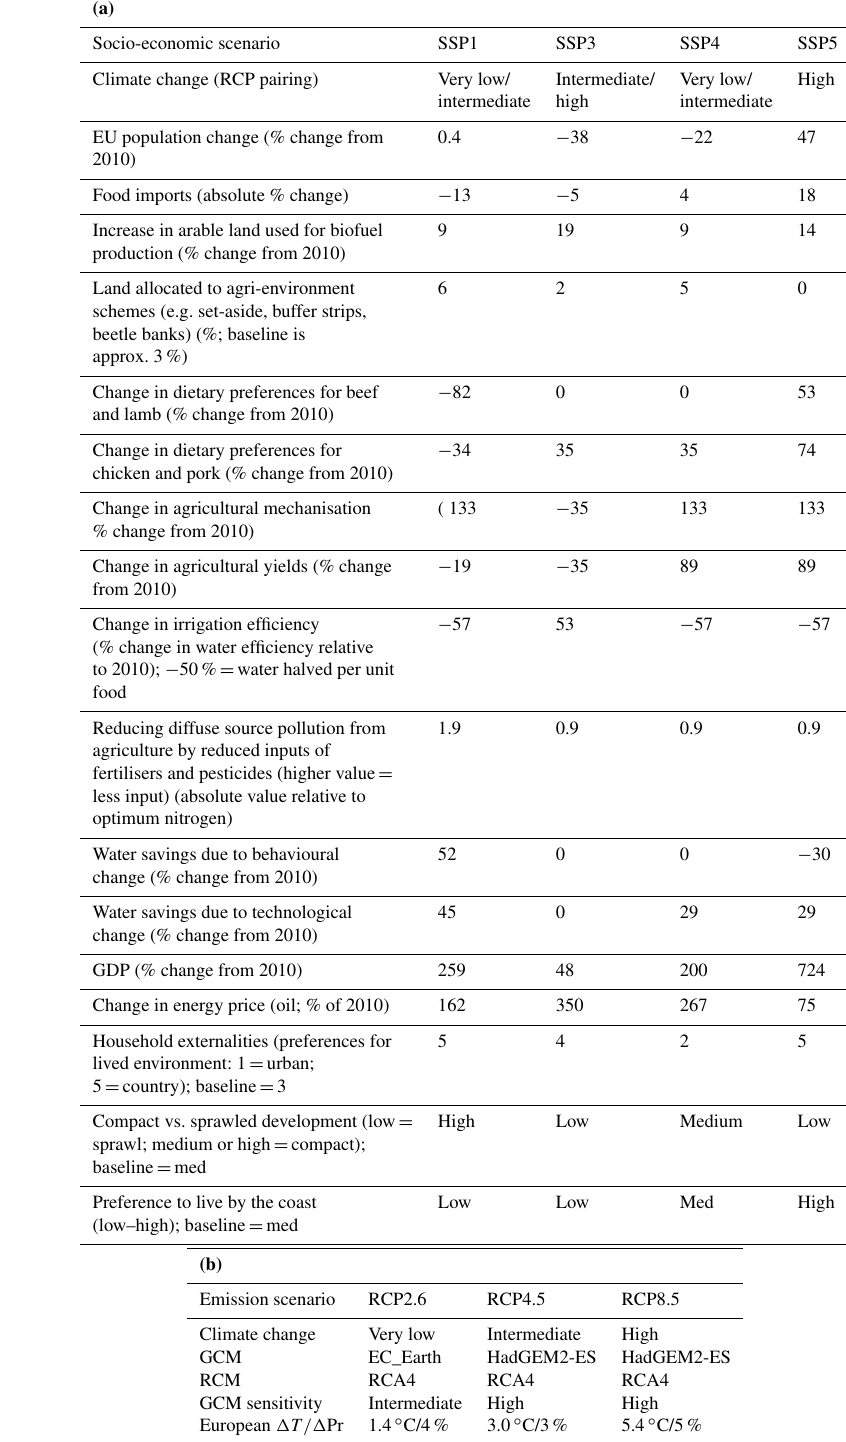
Table 2. (a) Details of the socio-economic scenarios (Shared Socioeconomic Pathways, SSPs) as simulated by the IAP. Values are shown for the 2080s time slice. Table adapted from Harrison et al. (2019). (b) Details of the climate scenarios used in both models. RCP denotes Representative Concentration Pathway. GCM: general circulation model, RCM: regional climate model. The change in temperature ( (cid:49)T ) and change in precipitation ( (cid:49) Pr) are relative to 1961–1990, and they affect productivities as simulated by meta-models in the IAP, which are then fed into the alternative land use models (Fig. 1). Further details are available in Harrison et al.